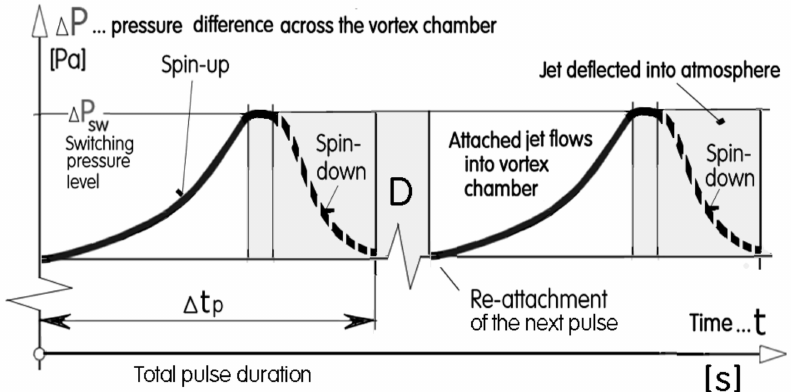
Figure 7. Examples of the sequence of two pressure pulses at the output of the shaper shown in Figure 6. Between the pulses there is a long time interval D. In response to the input pulse arrival uniform output pulses are generated shown here as their time dependence on the pressure di ff erences ∆